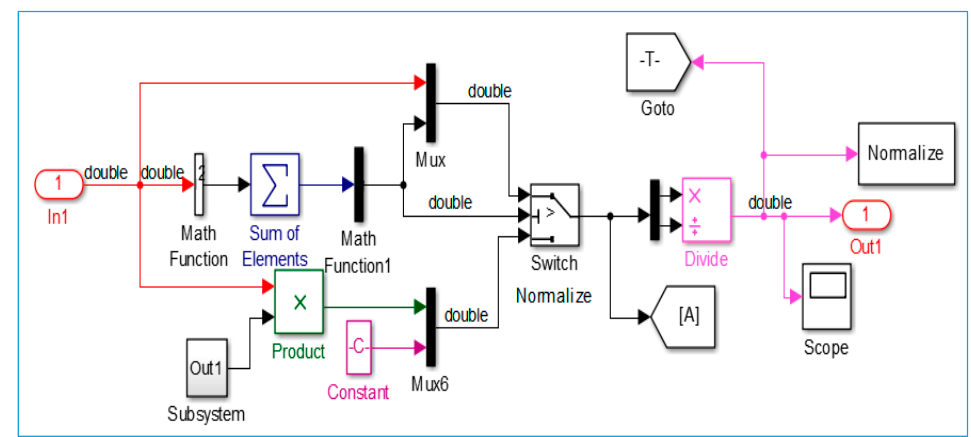
Figure 3. Implementation of decision maker (HSBP—ANFIS).